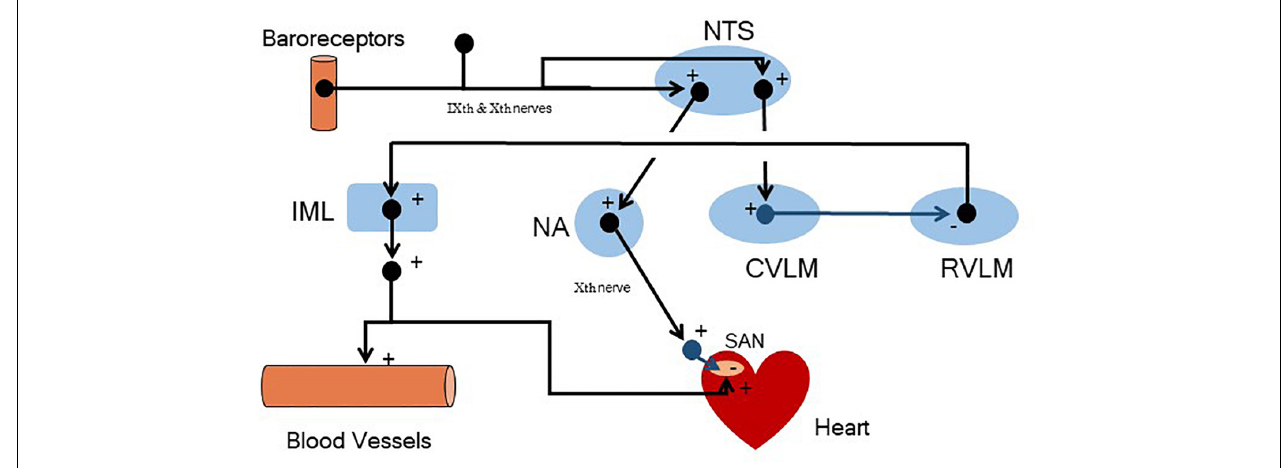
FIGURE 8 | A simplified schematic representation of the central neural structures involved in baroreceptor reflex regulation of arterial blood pressure. Arterial pressure receptors located in the carotid sinuses and aortic arch (nerve firing increases as arterial pressure increases) convey afferent information via the glossopharyngeal (IXth) and vagus (Xth) nerves to the brain, respectively. This information is first processed by neurons located in the nucleus tractus solitarius (NTS). The NTS then alters parasympathetic and sympathetic efferent nerve activity. Specifically, the NTS alters the activity of neurons (monosynaptically) located in the nucleus ambiguus (NA, parasympathetic pre-ganglionic neurons) and neurons (polysynaptically, via interneuron connections) in the caudal ventrolateral medulla (CVLM). The CVLM, in turn, regulates the tonic sympathetic activity that originates in the rostral ventrolateral medulla [RVLM, that regulates sympathetic pre-ganglionic neurons located in the intermediolateral column (IML) of the spinal cord]. + = excitatory neurotransmitters (shown in black); – = inhibitory neurotransmitters (shown in blue); SAN = sino-atrial node. As an example, an increase in arterial blood pressure would increase baroreceptor nerve firing, increasing NTS neuron activity which, via interneurons, would trigger both an increase in the activity of the parasympathetic pre-ganglionic neurons located in the NA and decrease the firing of sympathetic pre-ganglionic neurons located in the IML (less directly via CVLM mediated inhibition of the tonic activity of the RVLM). The net result would be a decrease in heart rate (? cardiac parasympathetic and ↓ cardiac sympathetic nerve activity), stroke volume ( ↓ cardiac sympathetic nerve activity), and arteriolar vasoconstriction ( ↓ total peripheral resistance, ↓ cardiac sympathetic nerve activity). Reductions in arterial blood pressure would provoke changes in the opposite direction. Note that the sign changes at the heart (parasympathetic effects on the SAN) and within the medulla (CVLM mediated inhibition of the RVLM). This “sign change” is necessary for negative feedback